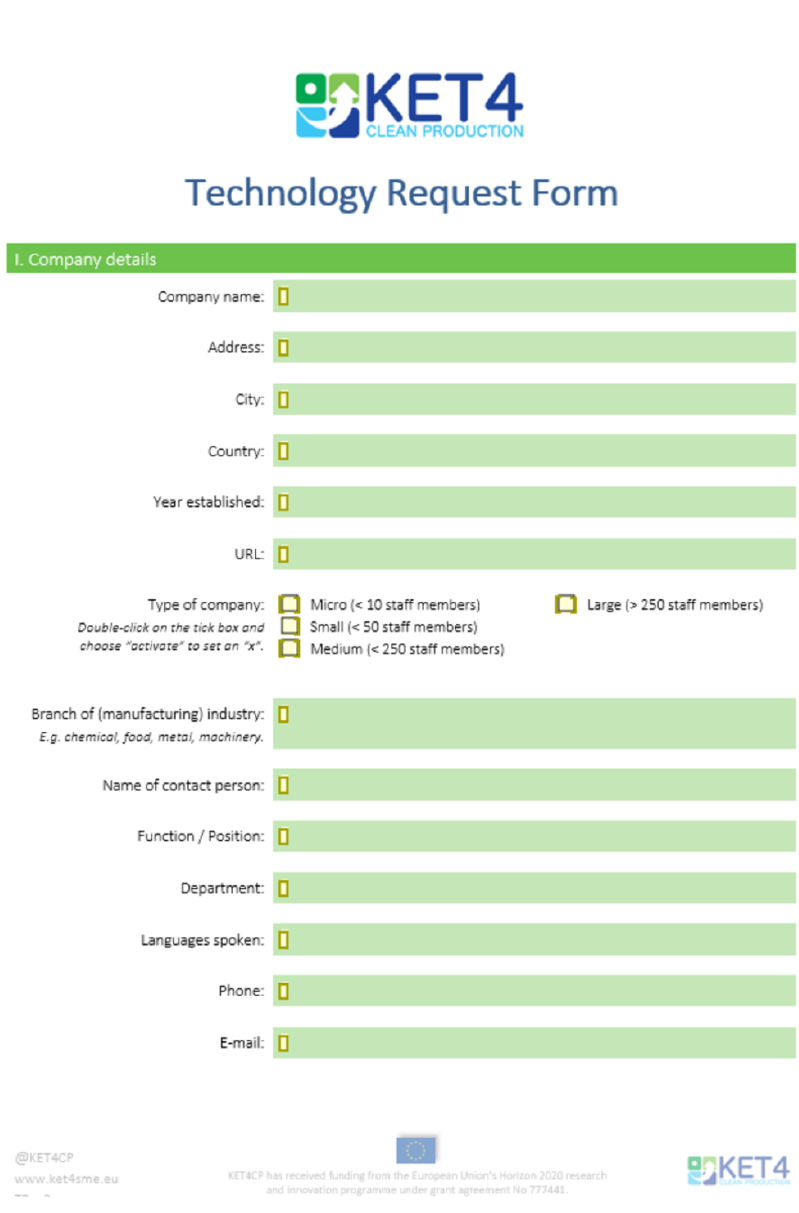
Figure A1. First page template TR.